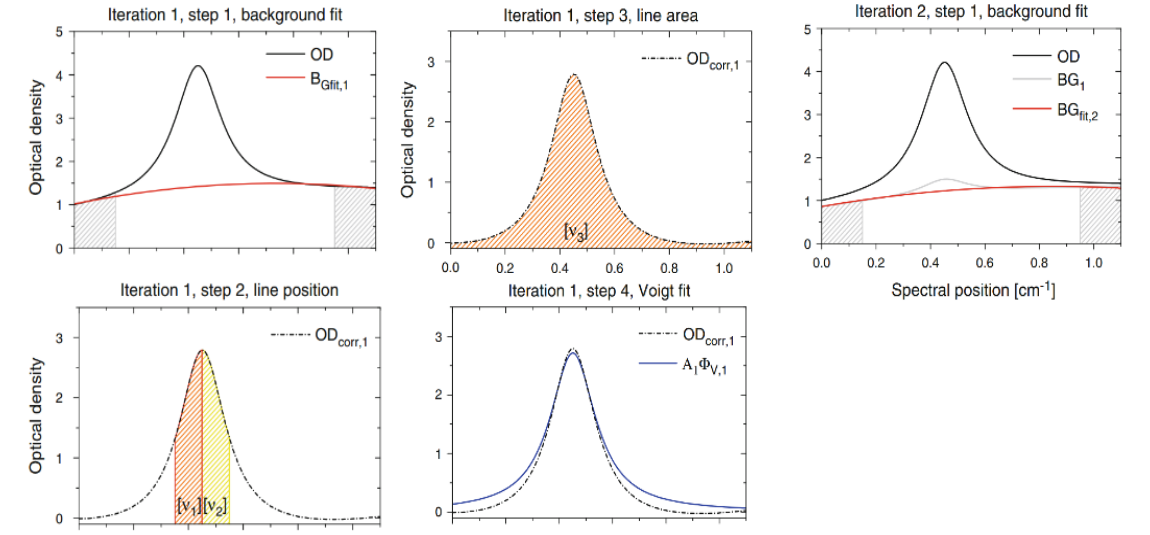
Figure 11. Steps of advanced integrative algorithm. This figure was obtained from [51].